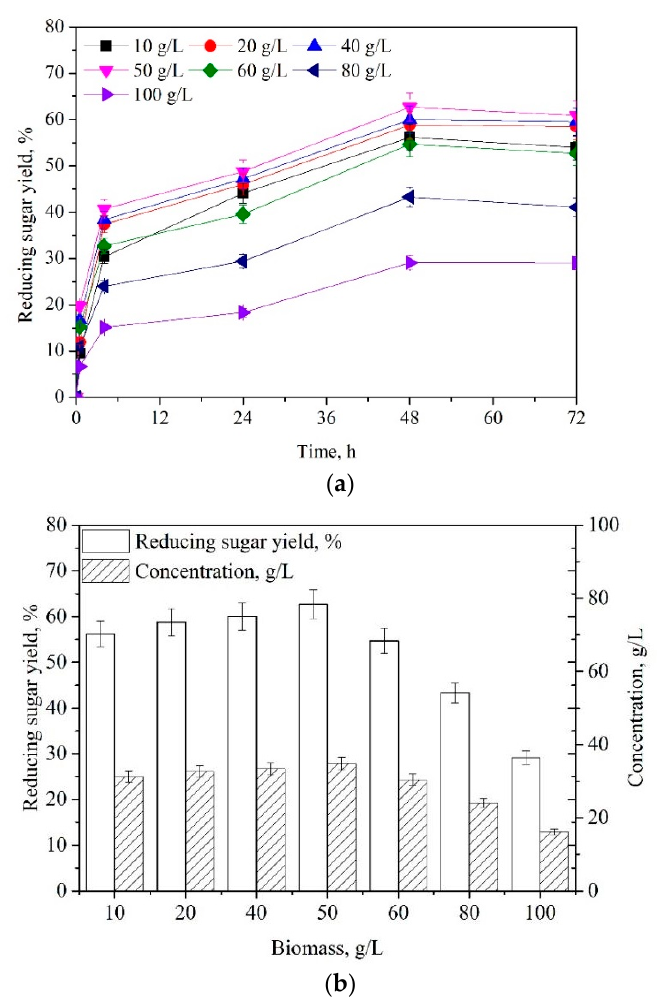
Figure 8. Time courses for the enzymatic hydrolysis of DNC-TS concentration (10–100 g/L) ( a ); Effects of DNC-TS concentration (10–100 g/L) on the enzymatic saccharification ( b ). [Enzymatic hydrolysis condition: cellulase (10.0 FPU/g TS) and xylanase (30.0 CBU/g TS), 50 °C, pH 4.8]. Lignocellulosic biomass consists of highly crystalline cellulose and hemicellulose polymers whereas lignin interacts with hemicellulose and cellulose to form a complex matrix [49–55]. NaOH (1 wt%) could remove 60.4% of lignin in corn stover at 70 °C for 1 h [55]. A combined ethylene glycol-HClO 4 -H 2 O (88.8:1.2:10, wt/wt/wt ) soaking at 130 °C for 0.5 h with NaOH (1 wt%) extraction at 90 °C for 1 h was utilized to treat chestnut shell,